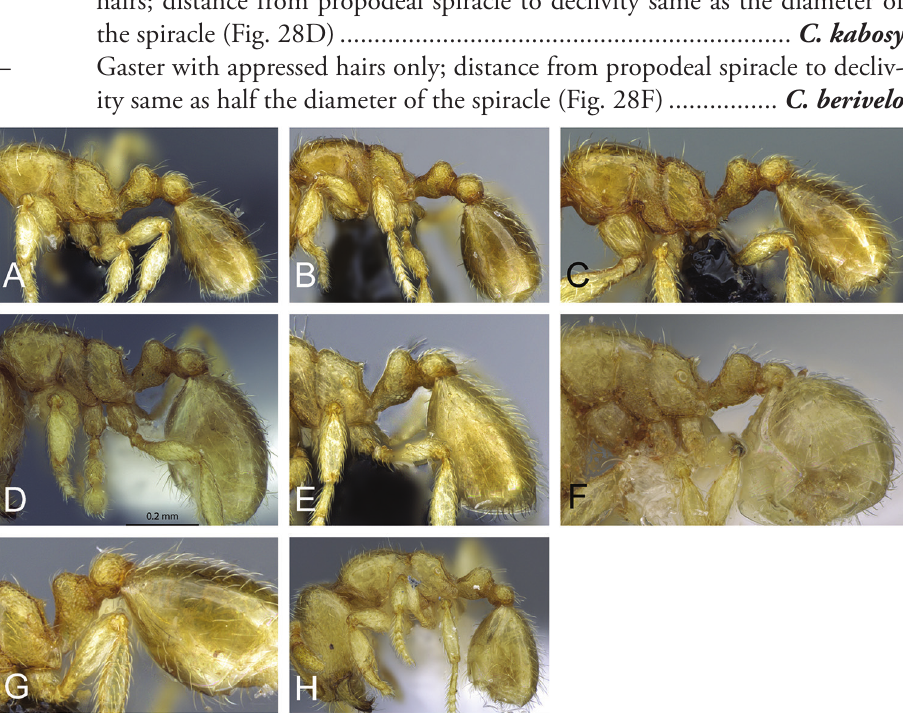
Figure 28. Mesosoma, petiole, postpetiole and gaster in profile view of A Carebara lova (CAS- ENT0468562) B Carebara omasi (CASENT0028947) C Carebara nosindambo (CASENT0073105) D Carebara kabosy (CASENT0437739) E Carebara jajoby (CASENT0037501) F Carebara berivelo (CASENT0439909) G Carebara raberi (CASENT0140575) H Carebara tana (CASENT0438084). Posterior margin of head nearly straight (Fig. 29A); gaster with short decum- bent hairs and fewer than ten long suberect hairs ........................... C. raberi